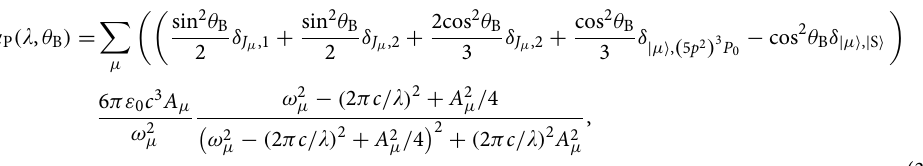
Figure 5. Dependence of dynamic polarizability of 88 Sr on light wavelength. Polarizabilities α j 88 Sr in j S, P as a function of the trapping-beam wavelength (cid:31) with θ B = crosses the α P curve (solid) at the red-detuned magic wavelength (cid:31) r (cid:31) (cid:30) 1, l r 49, m r ) WGMs with m r TE-polarized ( n r (cid:31) = = ± α S α P is much smaller than α S,P . The wavelength λ the difference �α = − ( n b 1, l b 109, m b 109 ) = = =